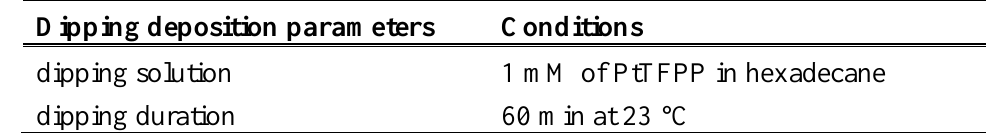
Table 1. Conditions of dipping deposition to prepare an AA-PSP as a global water sensor.